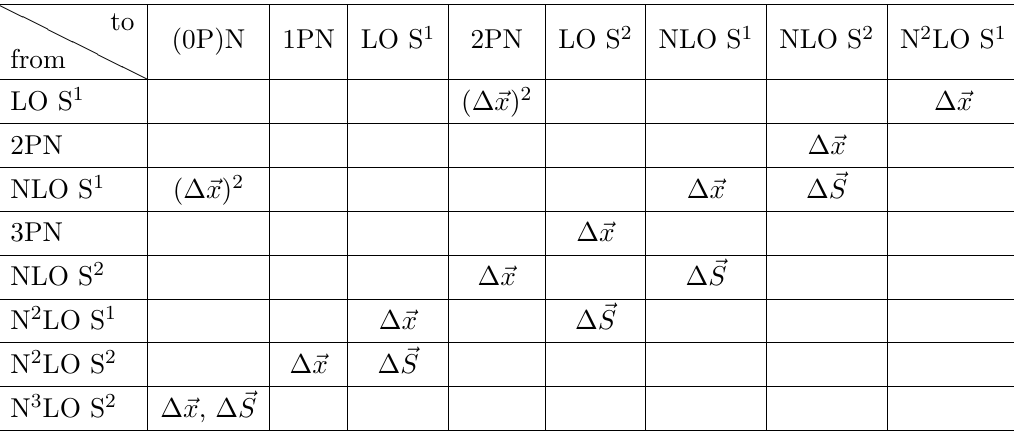
Table 5 . Contributions to the N 3 LO S 2 sector from position shifts and spin redefinitions in lower- order